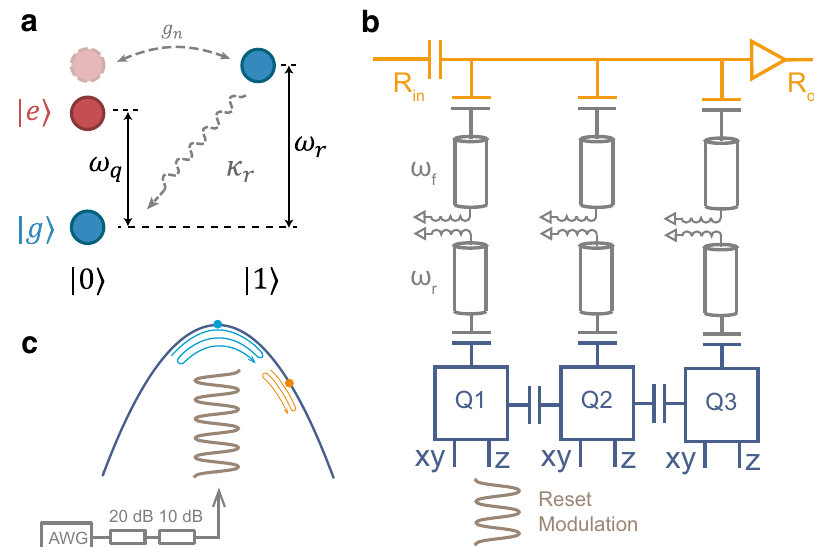
Fig. 1 Schematic of the reset process and diagram of the device. a Jaynes-Cummings ladder diagram of the qubit-resonator coupled system. g j i , e j i and 0 j i , 1 j i denote the qubit and resonator lowest two states respectively. The dashed light red circle represents one of the sideband modes induced by the parametric modulation. The dashed arrow labeled κ r illustrates the decay process of the resonator. b Simpli fi ed circuit diagram of the chip. Each transmon qubit is coupled to a readout resonator and an individual Purcell fi lter. The readout signal is ampli fi ed by an impedance-matched Josephson parametric ampli fi er (IMPA). c Typical transmon resonance frequency ω q with respect to the fl ux bias. The reset pulse is generated by AWG. After 30 dB attenuation, it is added to the fl ux control line. The qubit ’ s frequency modulation (brown) activates effective coupling between the qubit and its readout resonator and facilitates the reset process. Two cases are depicted: (1) operation point at or near the sweet spot (cyan, main text); (2) operation point away from the sweet spot (orange, Supplementary Note